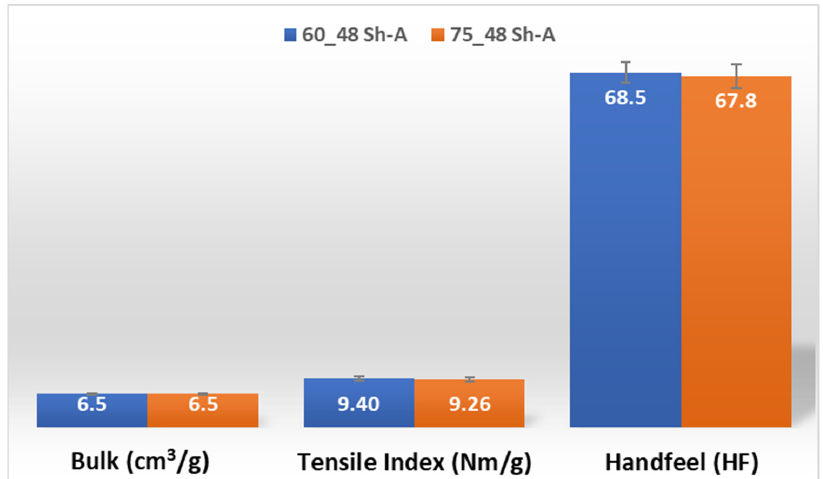
Figure 11. Bulk, tensile index, and handfeel results for deco embossing and configuration 2 rubber hardness conjugation.